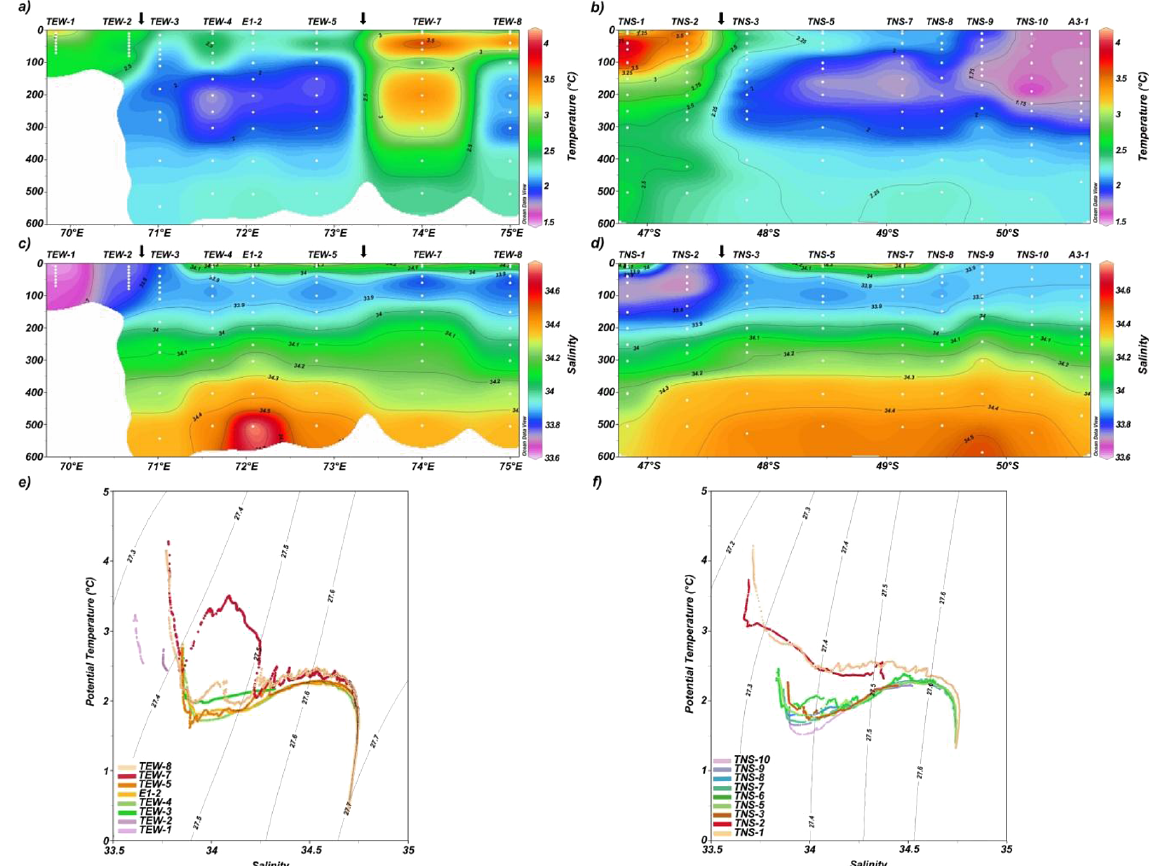
Figure 2. Left column: (a) Temperature ( T ◦ C), (c) salinity and (e) temperature–salinity ( T – S ) diagram for the TEW. The station located close to the PF (purple) is shown, showing enhanced water mass mixing. Arrows indicate the position of the PF crossing this transect. Right column: (b) temperature ( T ◦ C), (d) salinity and (f) T – S diagram for the